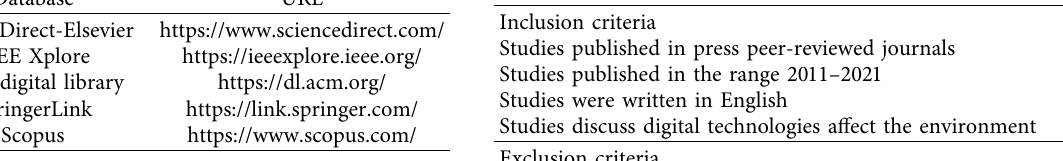
Table 2: Inclusion and exclusion criteria were utilised in the re- search process.